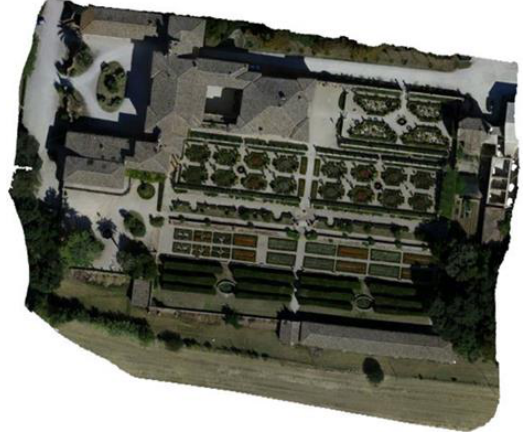
Figure 4. Orthoimage